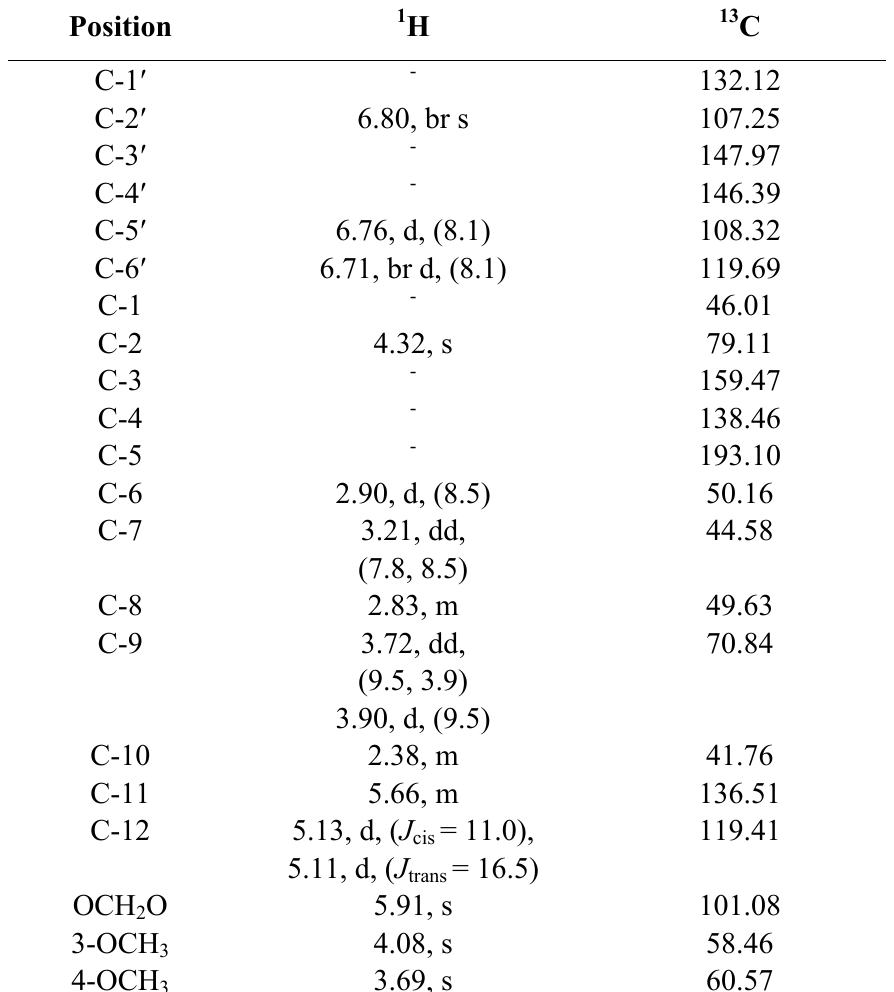
( δ in ppm, J in 3